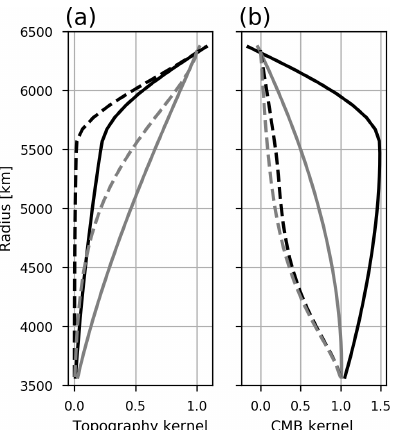
Figure 3. Topography and CMB kernels calculated using the prop- agator matrix approach (Hager and O’Connell, 1979). The black line is computed using a two-layer viscosity structure, the grey line uses a constant viscosity. The solid line is for spherical harmonic degree 2 and the dashed line for spherical harmonic degree